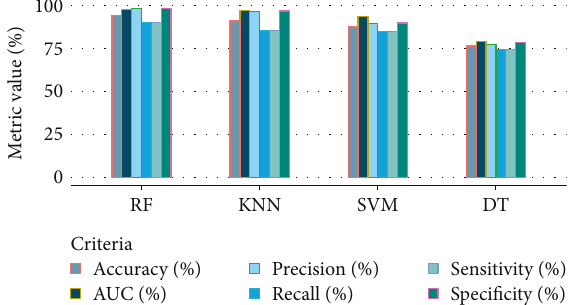
Figure 9: Performance of di ff erent classi fi cation models for IDU